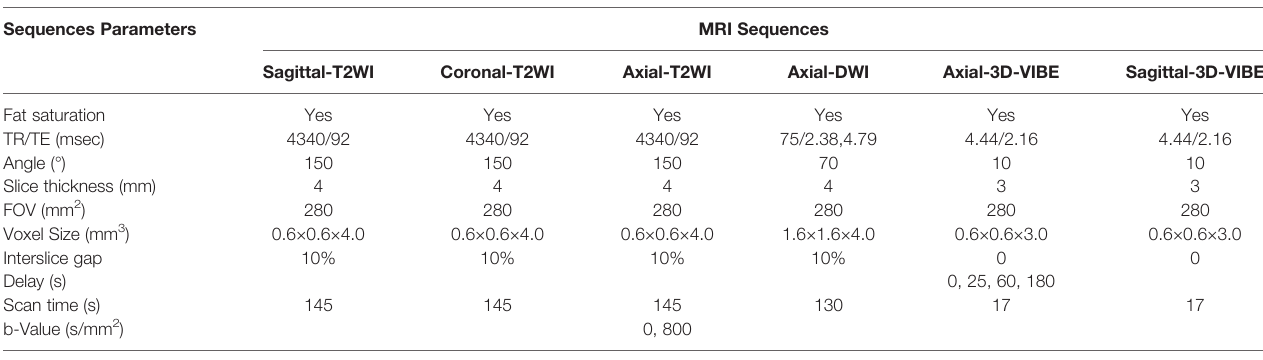
TABLE 1 | MRI protocol for